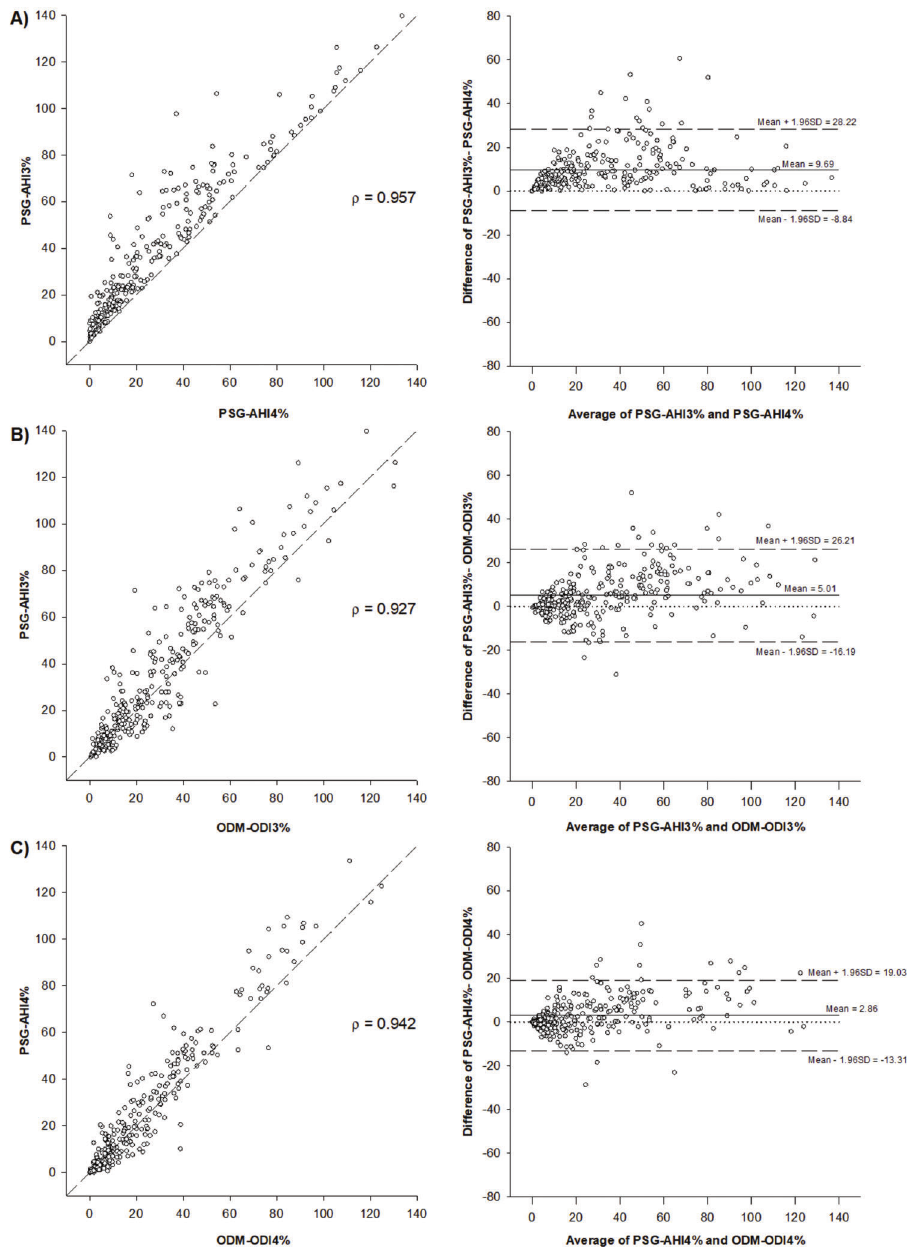
Figure 2 - Scatter plots and Spearman’s correlation (r) and Bland-Altman plots comparing A) PSG-AHI3% and PSG-AHI4%, B) PSG- AHI3% and ODM-ODI3%, and C) PSG-AHI4% and ODM-ODI4%.PSG=polysomnography; AHI=apnea-hypopnea index; ODM=overnight digital monitoring; ODI=oxygen desaturation